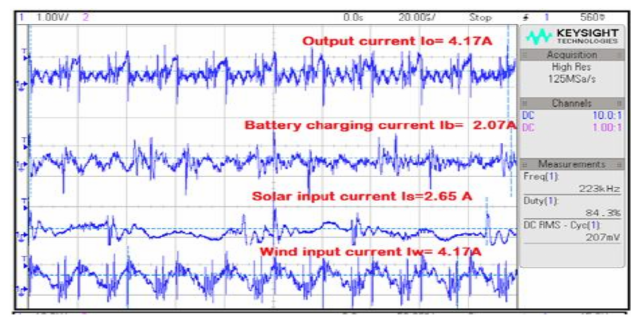
Figure 15. Battery charging